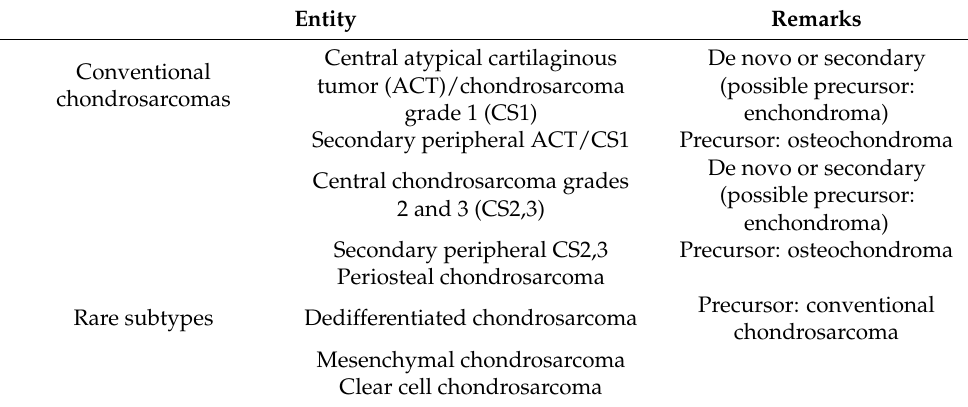
Table 1. 2020 WHO classification of chondrosarcomas